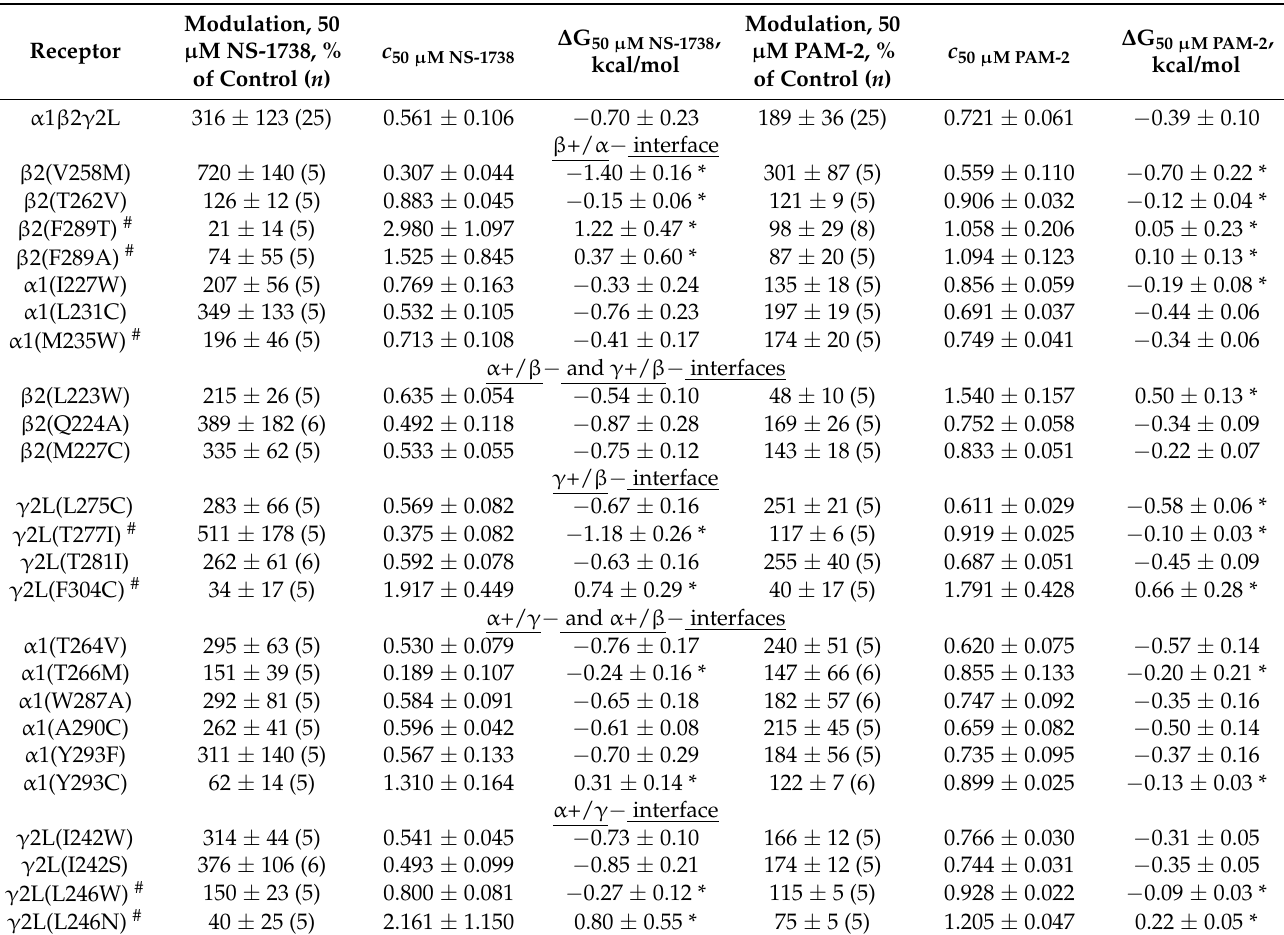
Table 1. Summary of effects of mutations on GABA A receptor potentiation or direct activation by the α 7-PAMs NS-1738 and